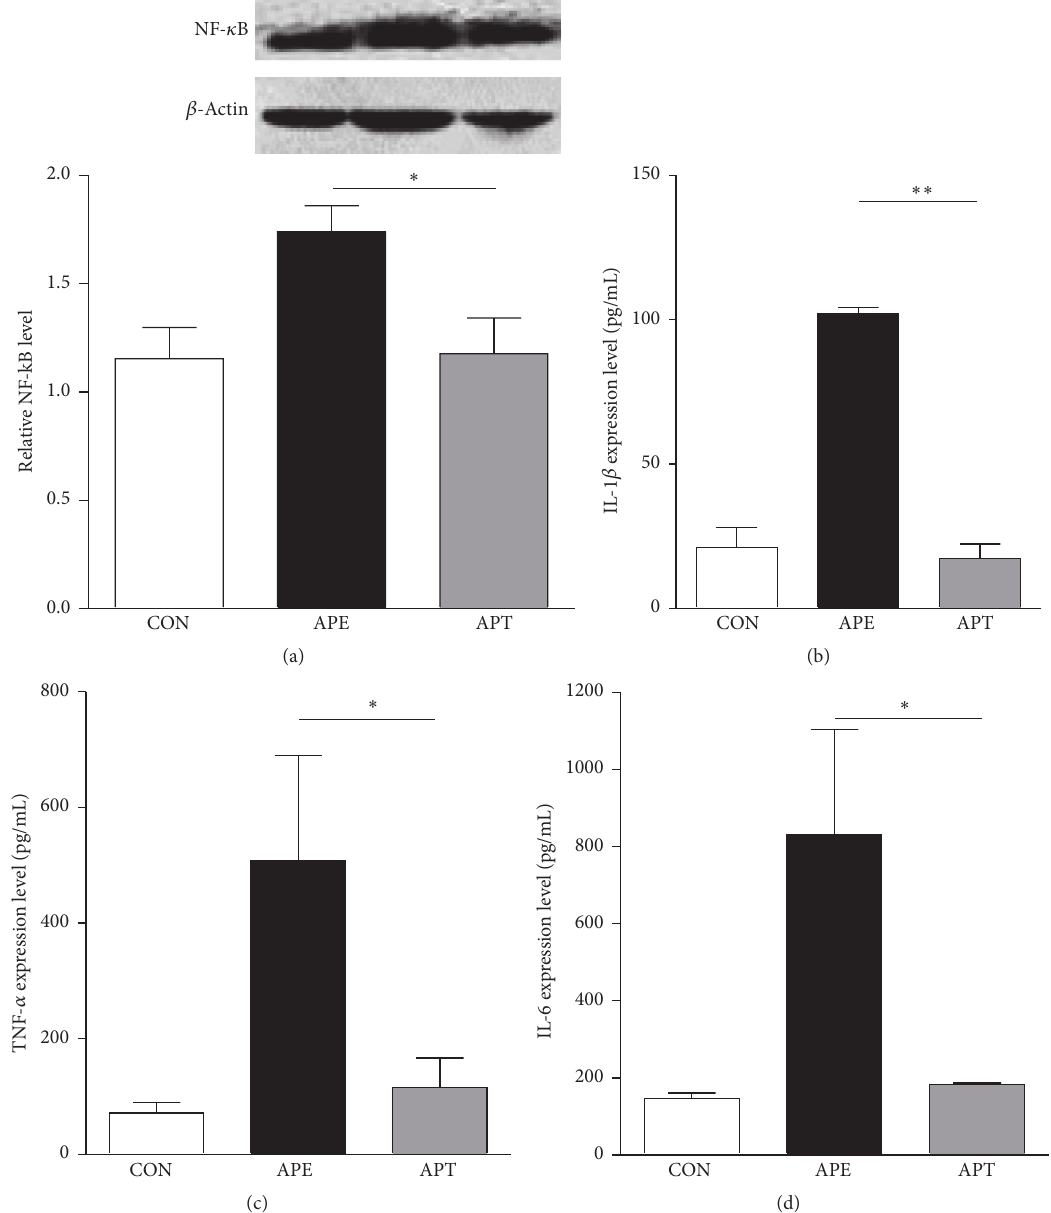
Figure 4: Expression of typical inflammatory modulators 2h after pilocarpine administration. (a) The relative NF- 𝜅 B level reduced 0.68 times in the hippocampus of the APT group compared to the APE group according to real-time qPCR and confirmed by WB; ((b)–(d)) the expression of TNF- 𝛼 , IL-1 𝛽 , and IL-6 reduced 0.22, 0.17, and 0.23 times in the hippocampus of the APT group compared to the APE group, respectively. Values are presented as the means ± SD ( ∗ 𝑝 < 0.05 ; ∗∗ 𝑝 < 0.01